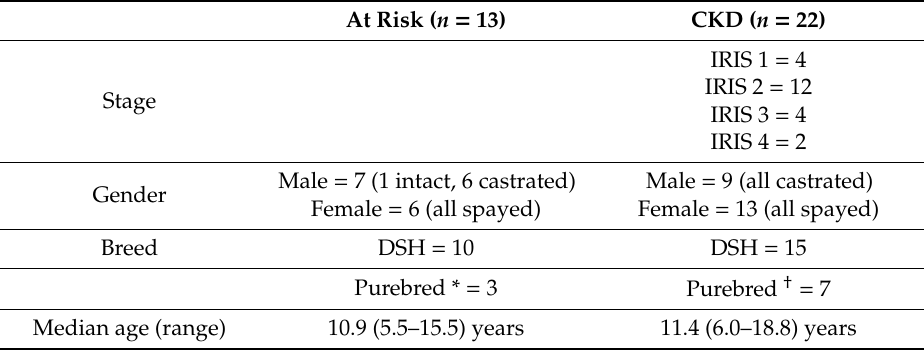
Median age (range)